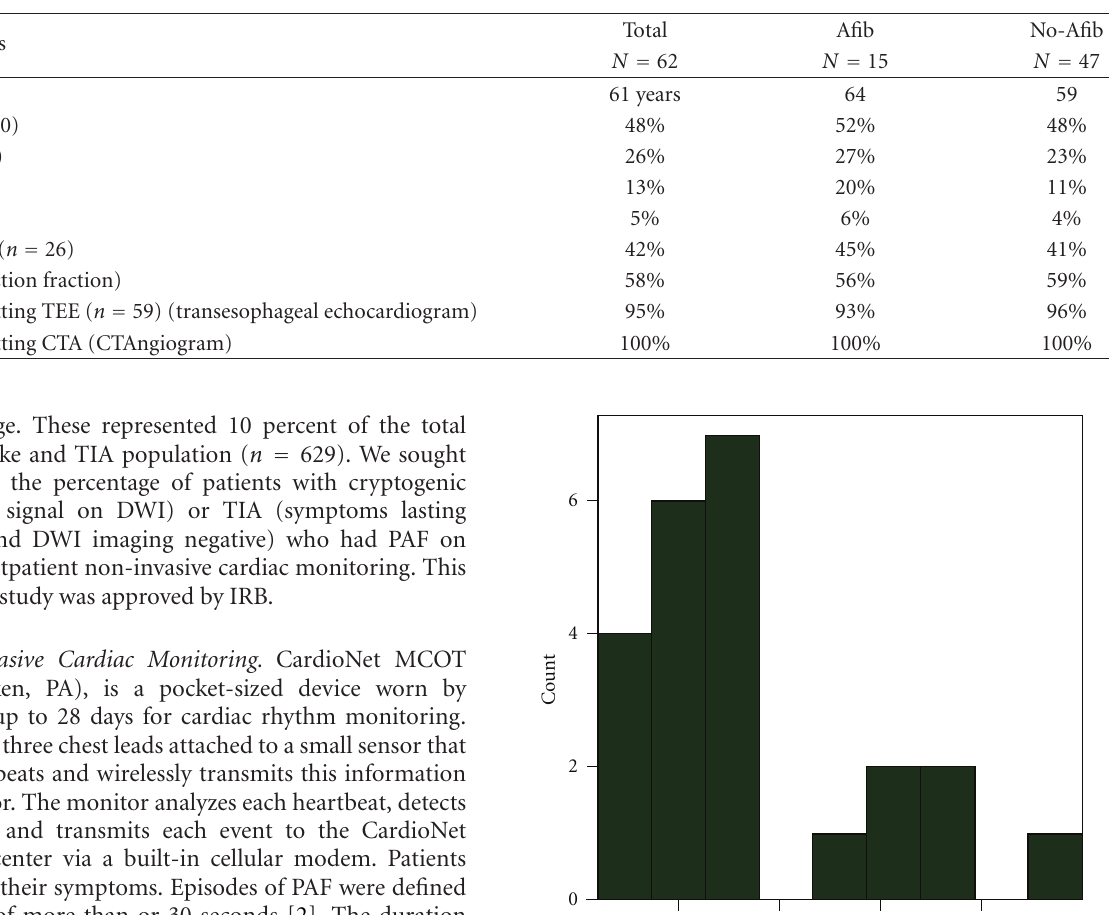
Table 1: Patient characteristics.